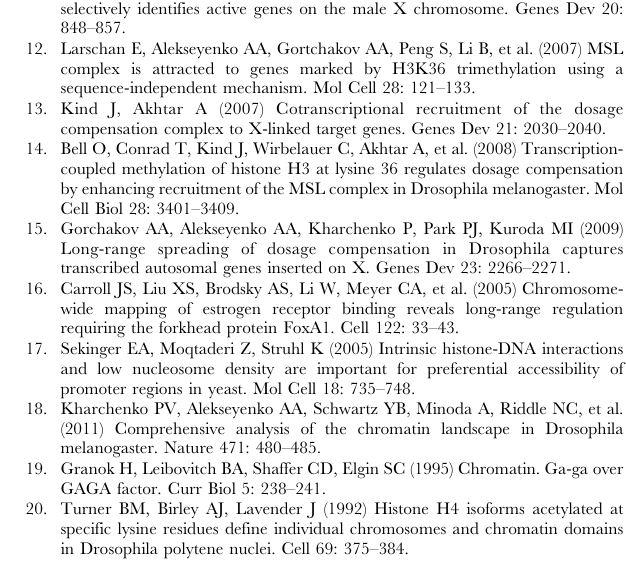
chosen as a threshold to distinguish active from inactive genes (red dotted lines). (B) Meta-gene profiles of JIL-1 and H1 in active and inactive genes of BG3 cells. (C) Meta-gene profiles of H4K16ac in active and inactive genes of S2 and Kc cells. Figure S6 Chromosome-wide enrichment of different histone marks. There is generally no significant difference between the enrichment distribution on chromosome X and the autosomes in female Kc cells. However, there is enrichment of H2B-ubiq and H3K36me3 and depletion of H1 and H4 in the male S2 and BG3 cell lines, suggesting X chromosome specific enrichment of certain